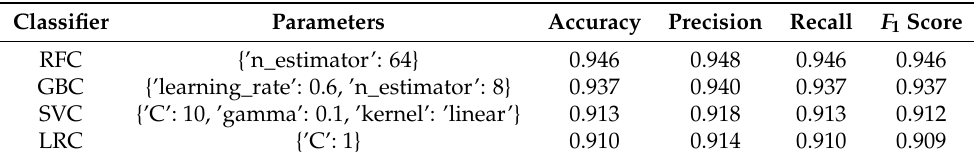
Table 11. Performance scores of the anxiety classifier using both activity tracking and minimal K-GAI assessment features on the training